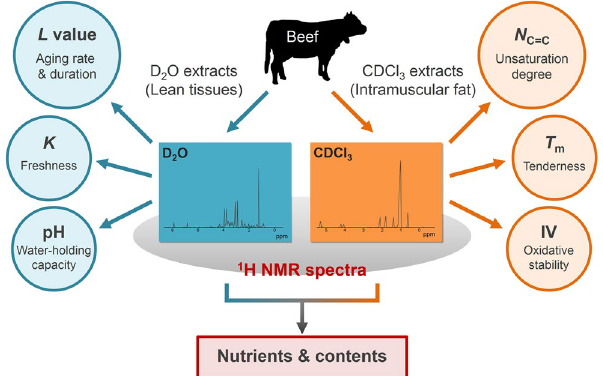
Figure 7. Multiple determinants of primary beef quality that are evaluated by the 1 H NMR spectra of metabolite extracts from lean tissues and intramuscular